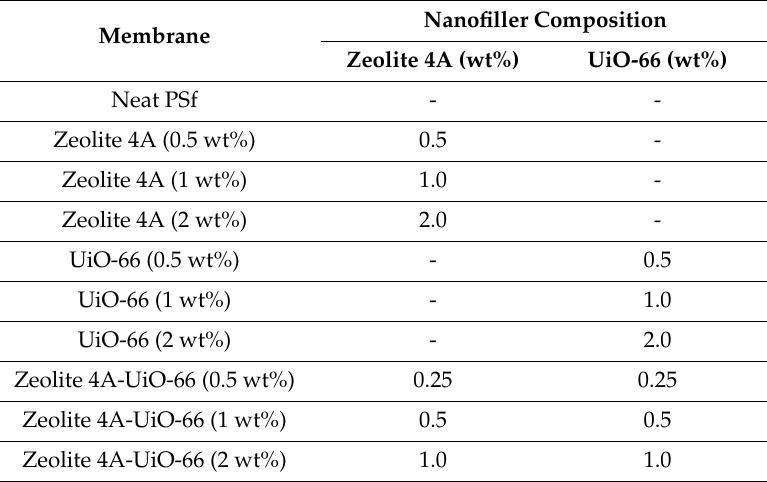
Table 1. Composition of